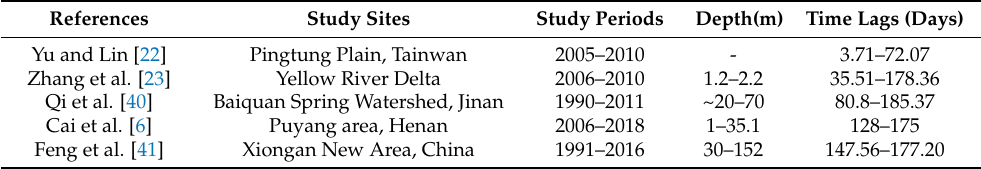
Table 5. Time lags of groundwater to rainfall at different study